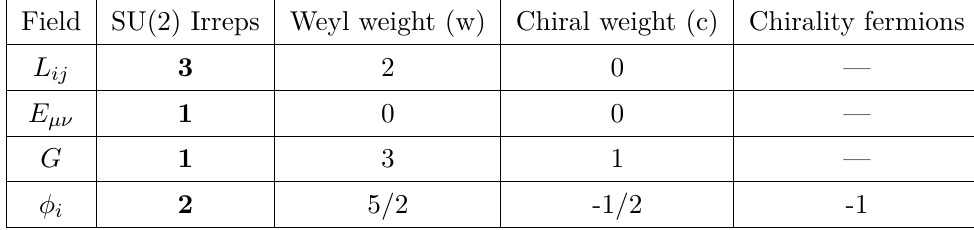
Table 3 . N = 2 superconformal tensor